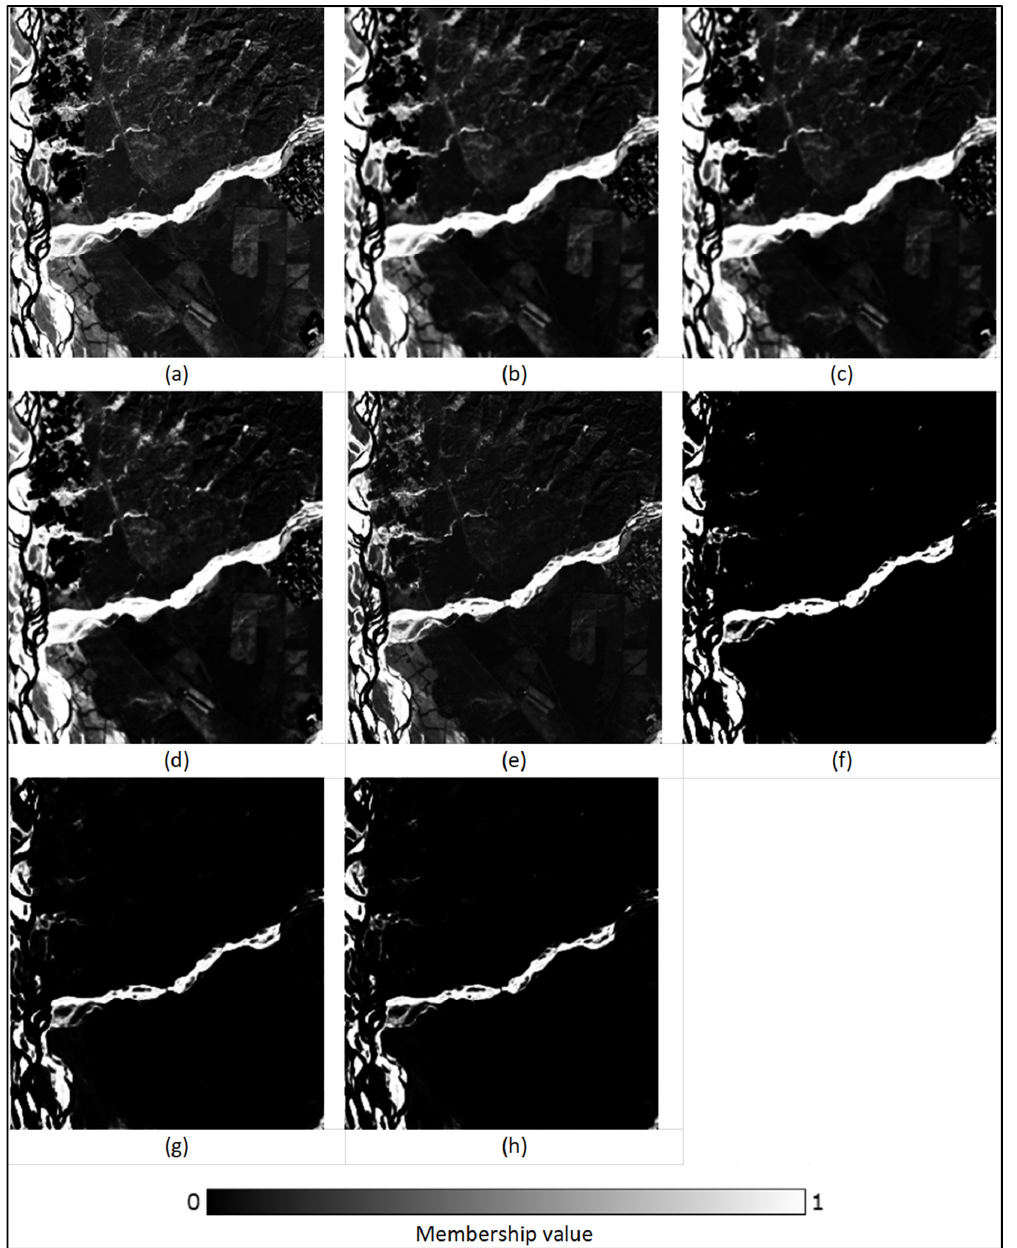
Figure 14. Membership fraction (0–1) for the class ‘Riverine Sand’ generated by ( a ) FCM, ( b ) FCM-S, ( c ) FLICM, ( d ) ADFLICM, ( e ) PCM, ( f ) PCM-S, ( g ) PLICM, and ( h ) ADPLICM classifiers in the presence of untrained classes.